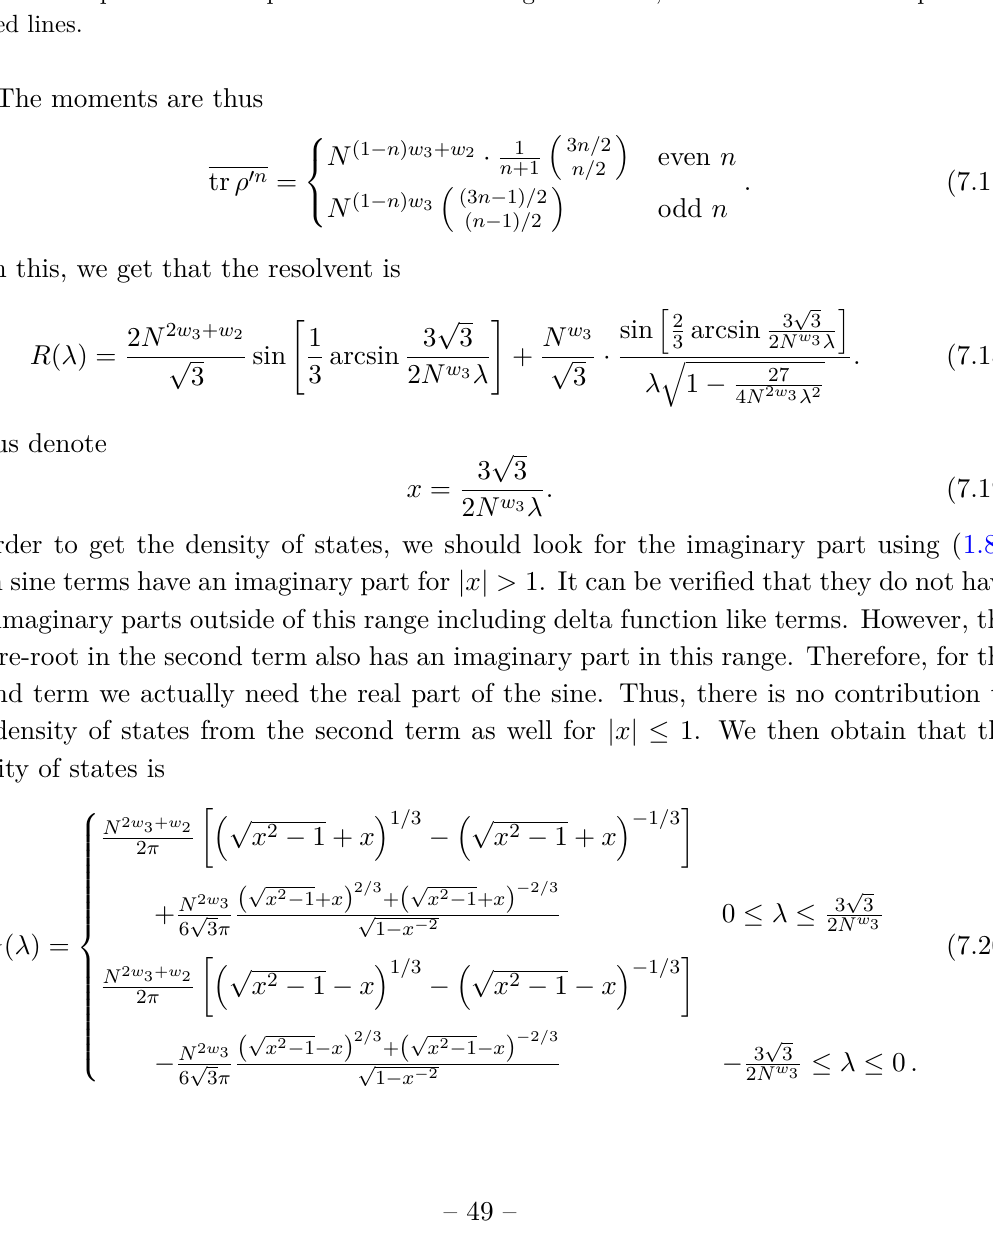
Figure 37 . Dual non-crossing partition to another non-crossing partition, also known as the Kreweras complement. One partition is shown using solid lines, while the other corresponds to dashed